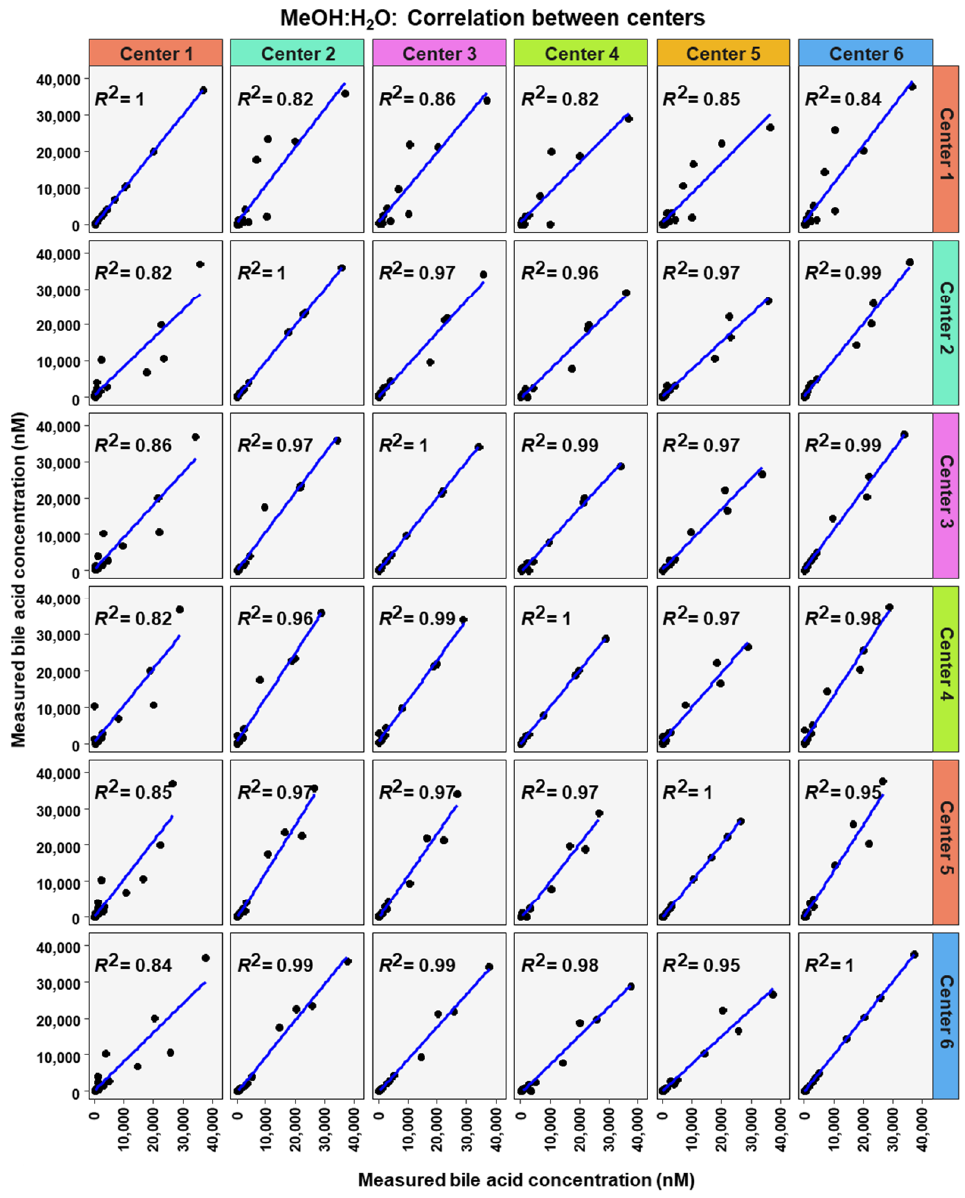
Figure 7. Correlation of bile acid quantification between assessing centers for measurements of bile acid in MeOH:H 2 O.